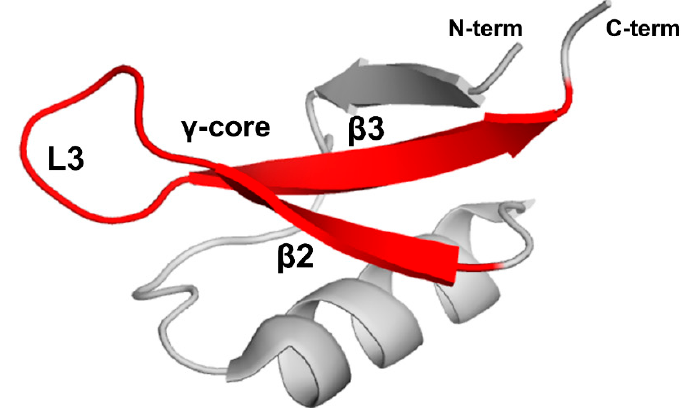
Figure 6. The γ -core motif. Introduced based on the consensus between all disulfide-containing antimicrobial peptides [97,98], the γ -core motif comprises two full-length beta-strands, β 2 and β 3, and loop L3 connecting them as shown by the red color on the three-dimensional structure of PsDef1 defensin (PDB code 5NCE) [51].